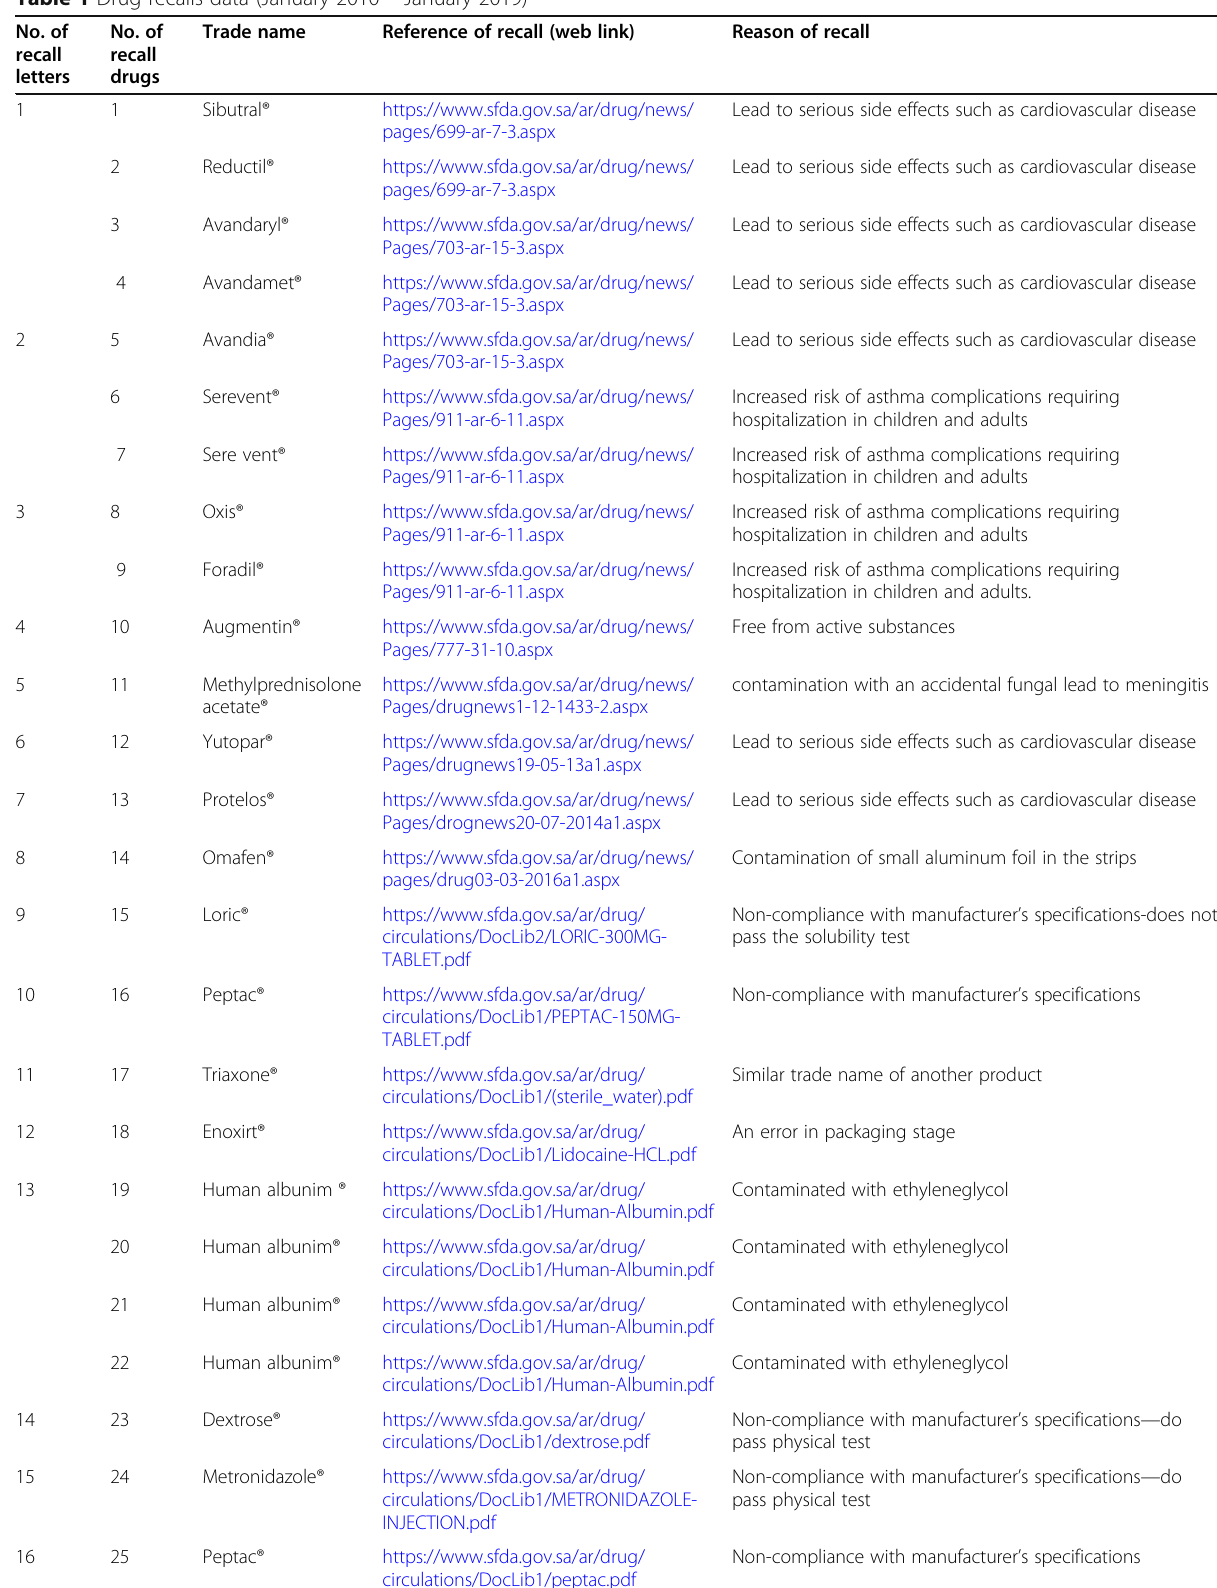
Table 1 Drug recalls data (January 2010 – January